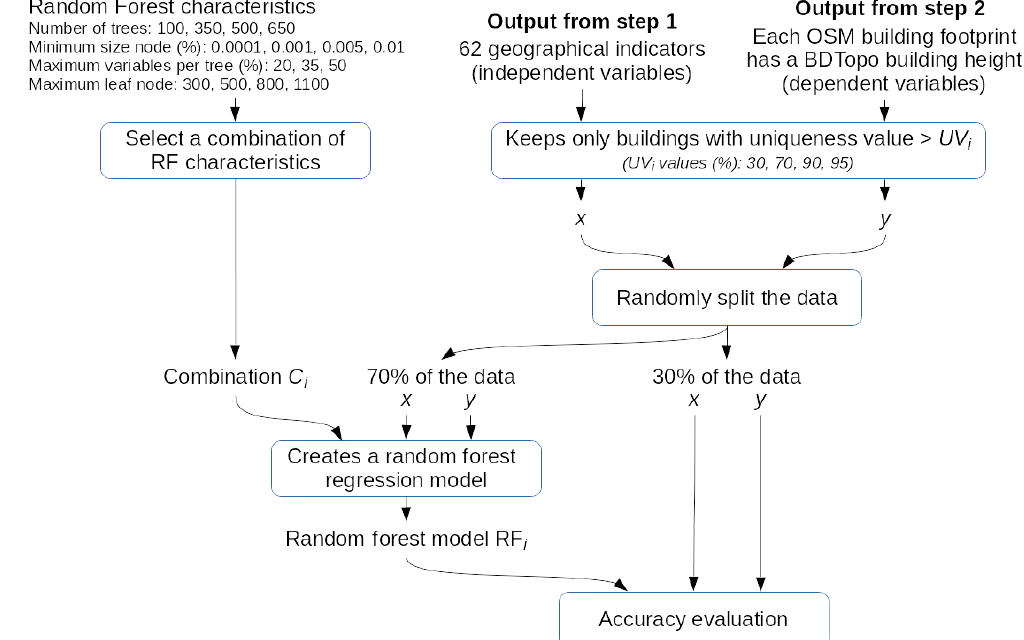
Figure 5. Method to train and optimize the random forest model. Only the training dataset is used at this step.